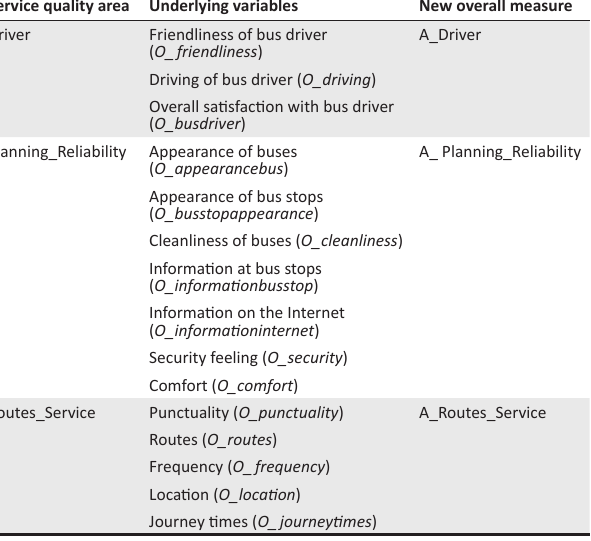
TABLE 12: New overall measures. Service quality area Underlying variables New overall measure